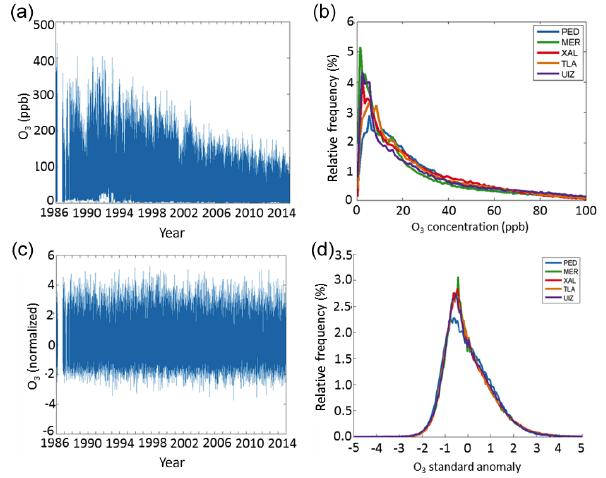
Figure 4. (a) Hourly observations of surface ozone concentrations (ppb) at Pedregal station (PED in Fig. 1). (b) Relative frequencies (in %) of hourly ozone concentrations (ppb) at five observing sta- tions, 1986–2014. (c) Standard anomalies of hourly surface ozone concentrations at PED. (d) Relative frequencies (in %) of standard anomalies of hourly ozone concentrations at five observing stations from the RAMA network,